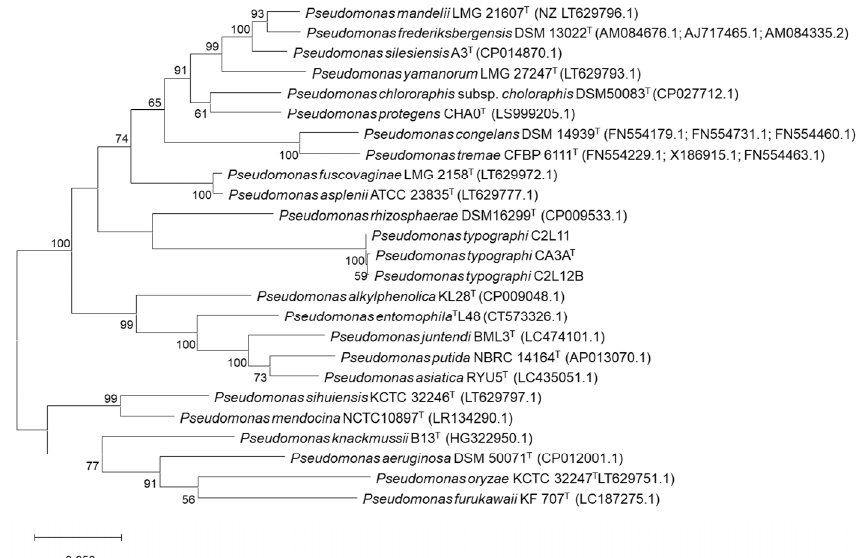
Figure 2. Maximum-likelihood phylogenetic tree based on concatenated partial gyrB , rpoB , and rpoD gene sequences of strains P. typographi CA3A T , C2L11, and C2L12B and closely related species of the genus Pseudomonas . Bootstrap values (expressed as percentages of 1000 replications) are shown at the branching points; values below 50 were discarded. Scale bar = 5 nucleotide (nt) substitutions per 100 nt. GenBank accession numbers of the sequences are indicated in parentheses.